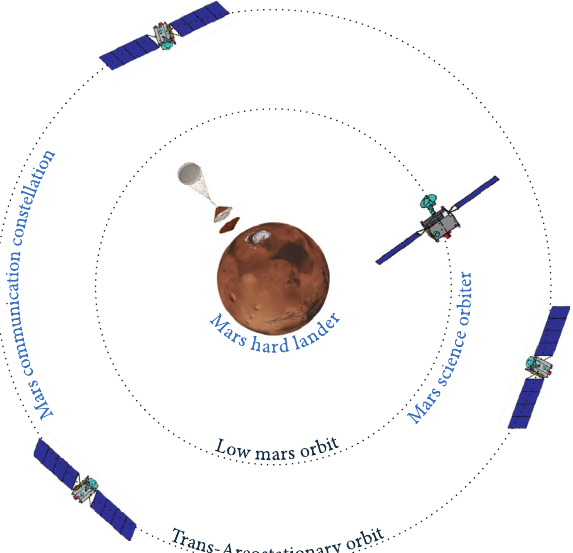
Figure 1: An overview of the three different mission cases studied in the CDF (not to scale).